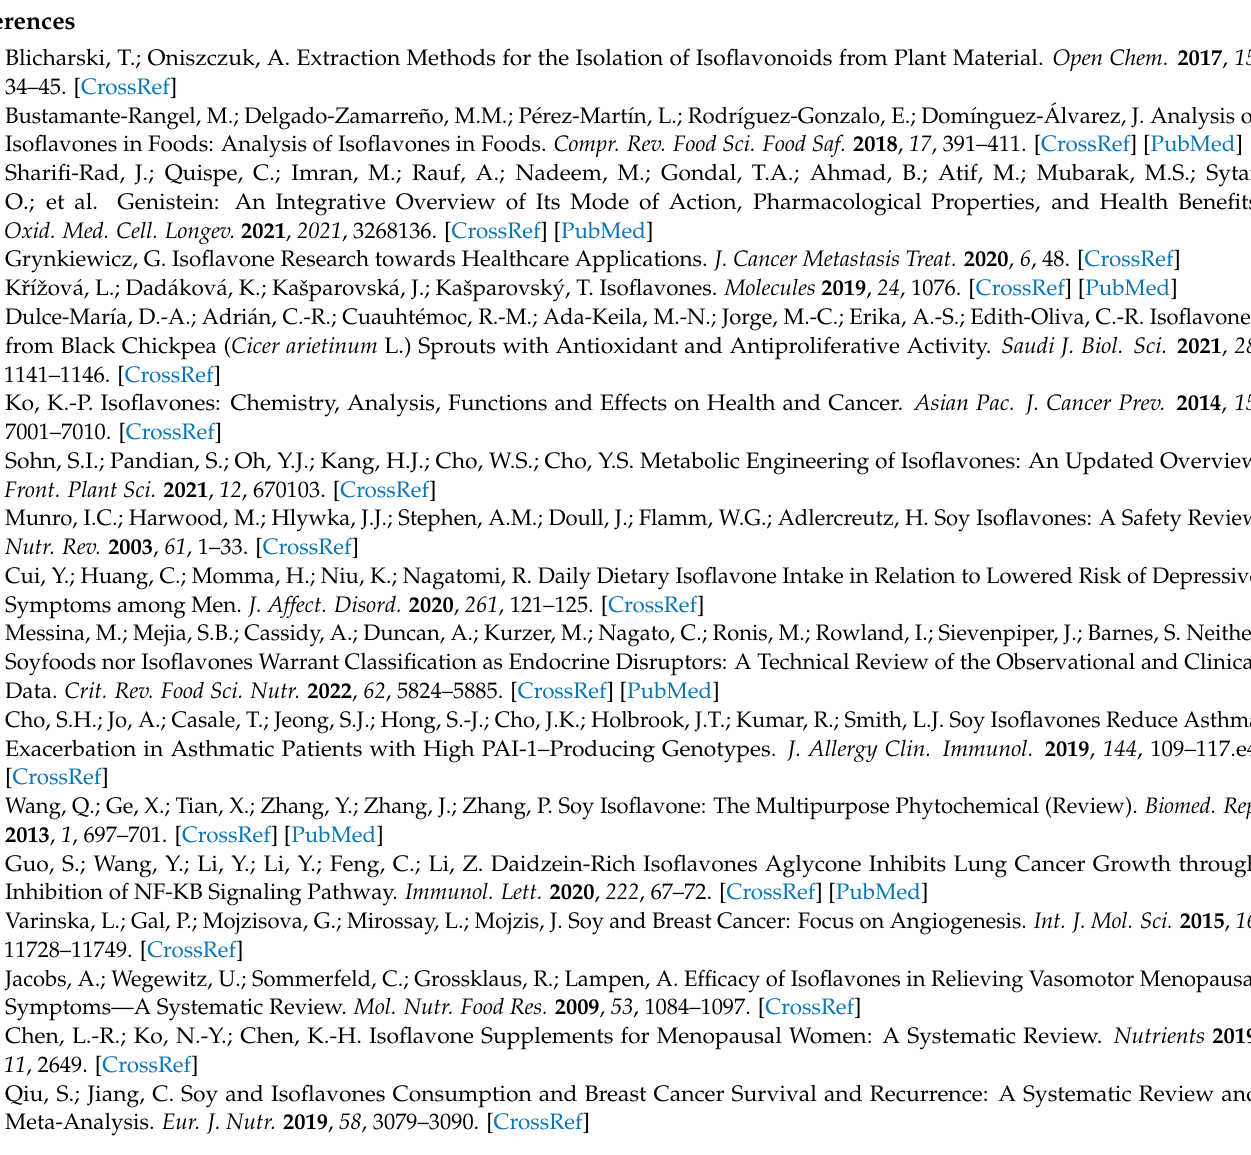
IR spectra for compound 4 . Figure S1: 1 H NMR spectrum (300 MHz) of compound 4 in DMSO- d 6 ; Figure S2: 13 C { 1 H} NMR spectrum (126 MHz) of compound 4 in DMSO- d 6 ; Figure S3: HRMS for compound 4 ; Figure S4: IR spectrum for compound 4